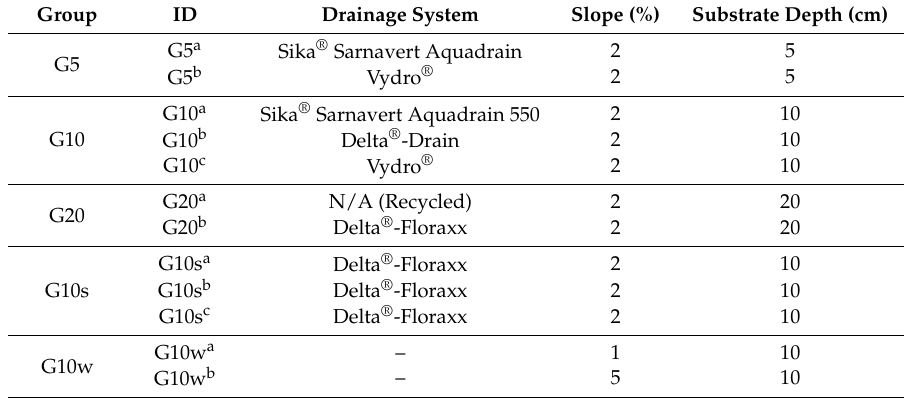
Table 1. Characteristics of each tested green roof specimen. Each specimen of a given group is identified with letters a, b or